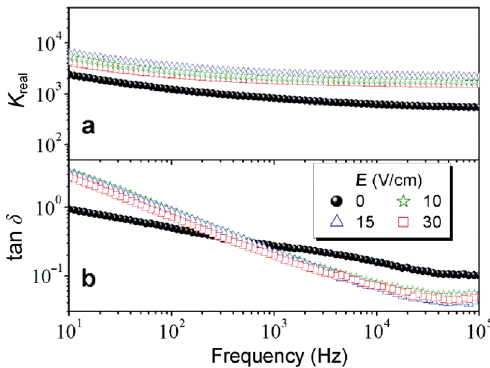
Fig. 9 Frequency dependence of (a) real part of dielectric constant ( K real ) and (b) dielectric loss (tan δ ) measured at room temperature for CCTO samples processed under E = 0, 10, 15, and 30 V·cm − 1